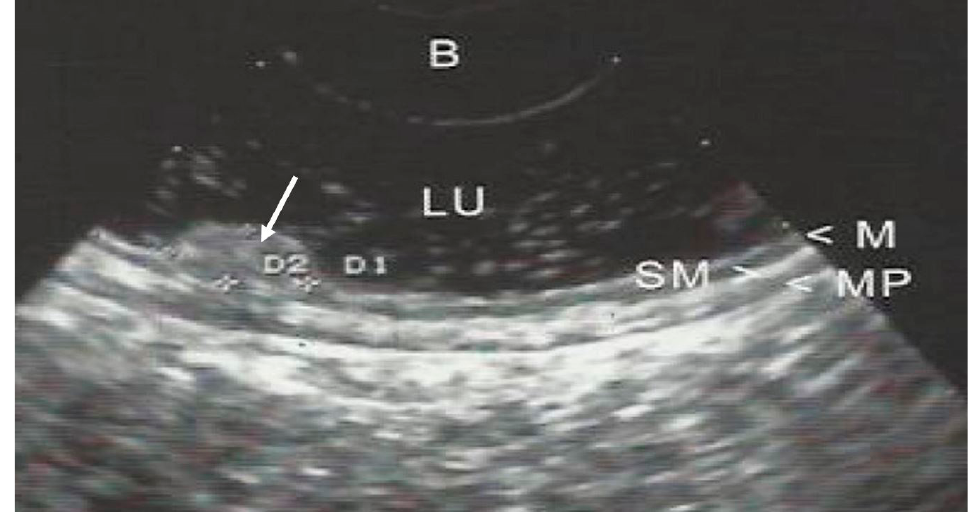
Figure 2. EUS of early gastric cancer at the lesser curvature of the gastric. Antrum with infiltration of the muscularis mucosae (arrow). Staging uT1m2, N0.